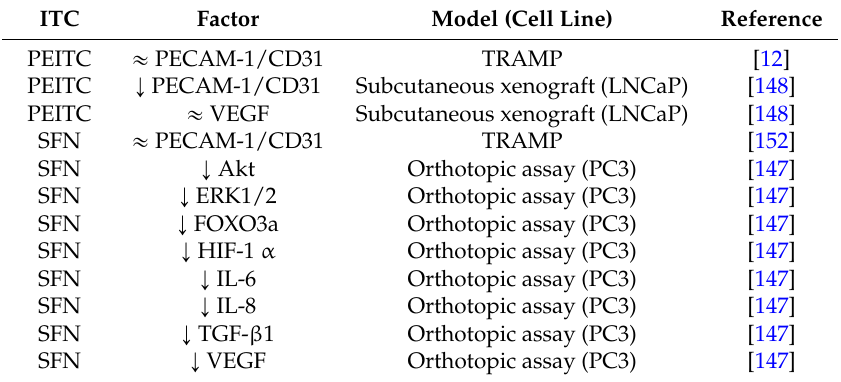
Table 9. ITCs inhibit the in vivo growth of prostate tumors by inhibiting angiogenesis. ITC Model (Cell